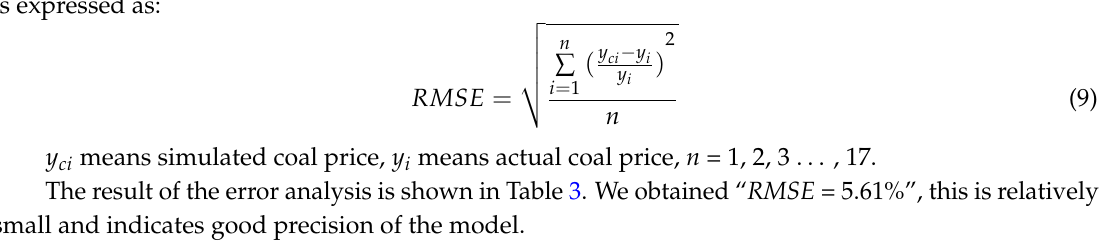
Table 3. Root mean square error ( RMSE ) analysis result of simulated coal price and actual coal price.